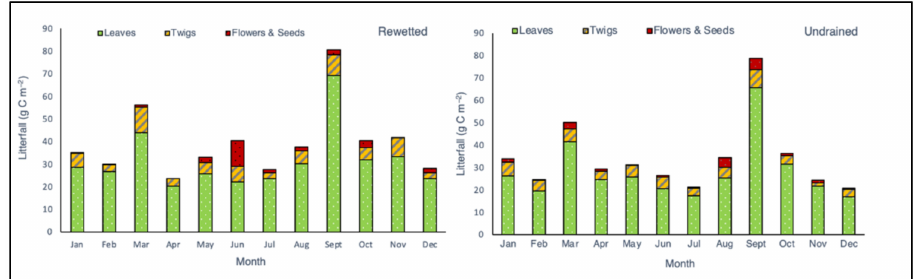
Figure 5. Monthly variation of litterfall production at the rewetted and undrained sites, Katingan, Central Kalimantan, Indonesia. The litterfall data were derived from one-year field data collection in